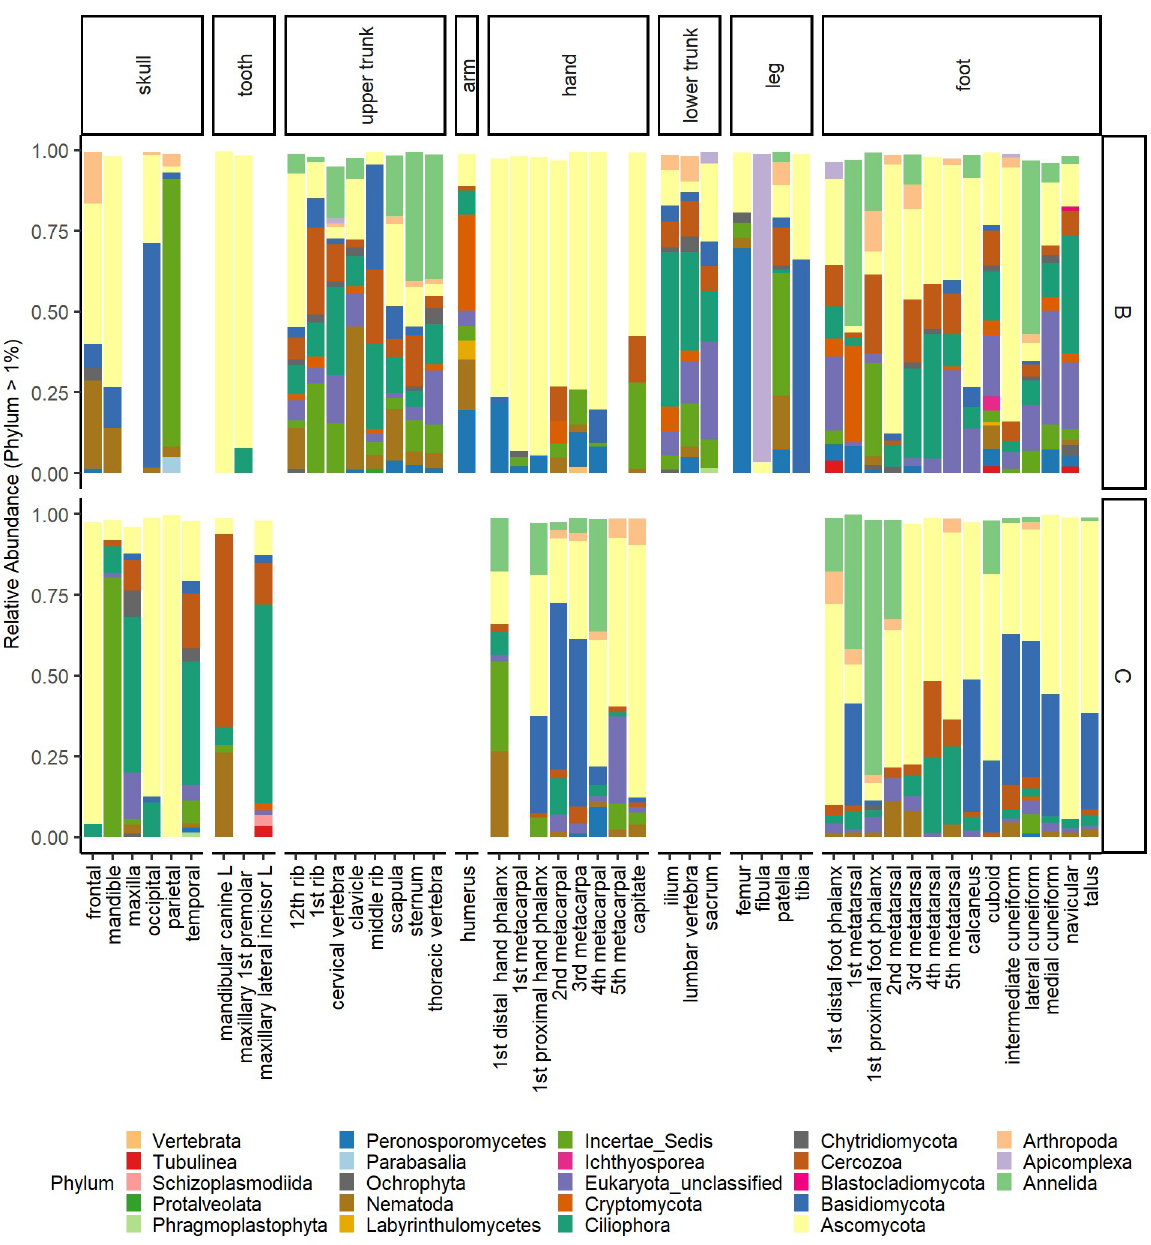
Fig 6. Relative abundance of eukaryotic phyla by bone type and individual. Relative abundance is shown for only those phyla with greater than 1% relative abundance, and for two of the three individuals (B and C). Data were not averaged by bone type. individual ( p = 0.001, F = 8.69, DF = 1), body region ( p = 0.001, F = 2.83, DF = 7), human DNA ( p = 0.02, F = 1.41, DF = 3), and cortical content ( p = 0.001, F = 1.60, DF = 5), with a sig- nificant interaction between body region and individual ( p = 0.001, F = 4.08, DF = 3), body region and human DNA ( p = 0.02, F = 1.25, DF = 4), and individual and cortical content ( p = 0.008, F = 1.72, DF = 1). Due to sequence loss, alpha diversity metrics were not computed. A random forest model was also applied to the microbial eukaryotic dataset to identify OTUs contributing to human DNA preservation. The resulting model was not significant,